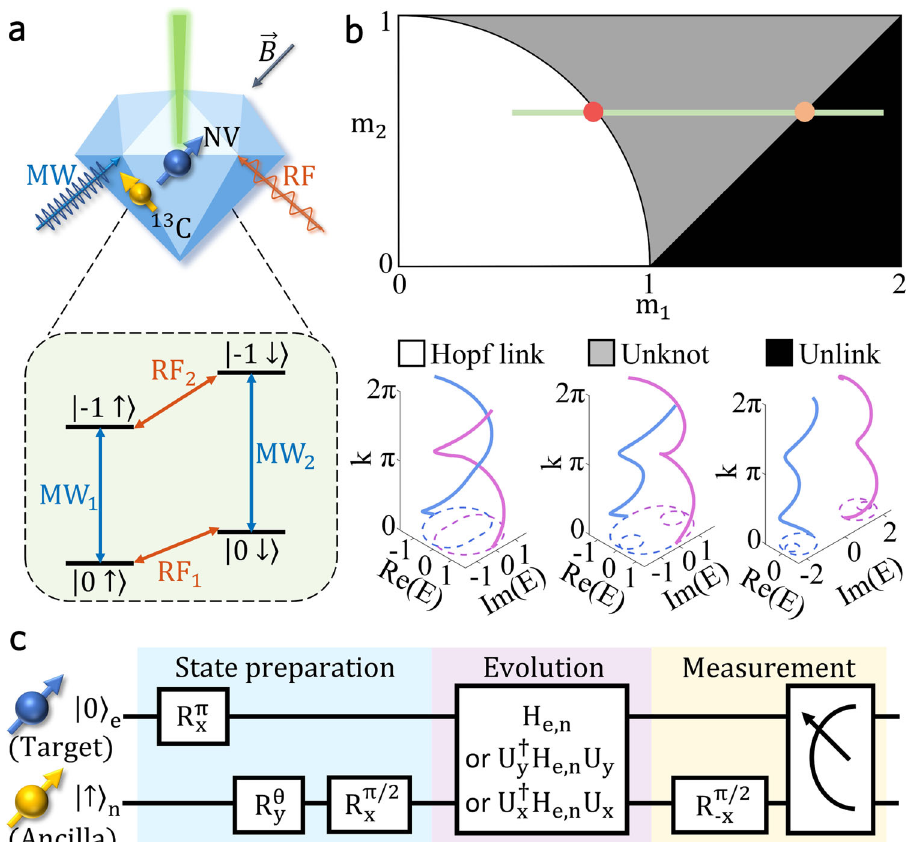
Fig. 1 Simulating the non-Hermitian twister Hamiltonian with knotted topological phases on the NV center platform. a Top: schematic illustration of the NV center in diamond. The system is coherently controlled by the microwave (MW) and radio frequency (RF) pulses. The NV electron spin (blue arrow) is coupled to a nearby 13 C nuclear spin (yellow arrow). Below: energy level diagram of the electron-nuclear spin system. MW controls the transitions between electron spin states { 0 j i , (cid:3) 1 j i }, and RF controls the transitions between nuclear spin states { "j i ; #j i }. b Top: phase diagram of the non-Hermitian twister model. We experimentally simulate the twister Hamiltonian with the parameters m 1,2 along the green line (crossing the two theoretical phase boundaries). Below: band structures of the twister model in the space spanned by ð Re ð E Þ ; Im ð E Þ ; k Þ , the momentum k is in the fi rst Brillouin zone. Gluing the k = 0 and k = 2 π planes leads to different knotted band structures, including the Hopf link (white square), the unknot (gray square), and the unlink (dark square). c Quantum circuit for simulating the non-Hermitian Hamiltonian in our experiment. Here we take the electron (nuclear) spin as the target (ancillary)